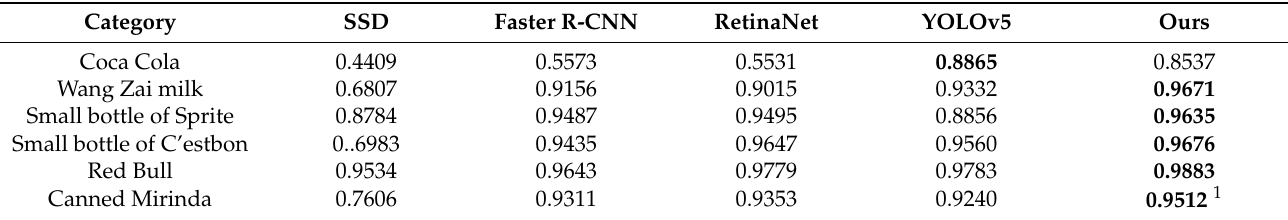
Table 7. The detection results of different commodity